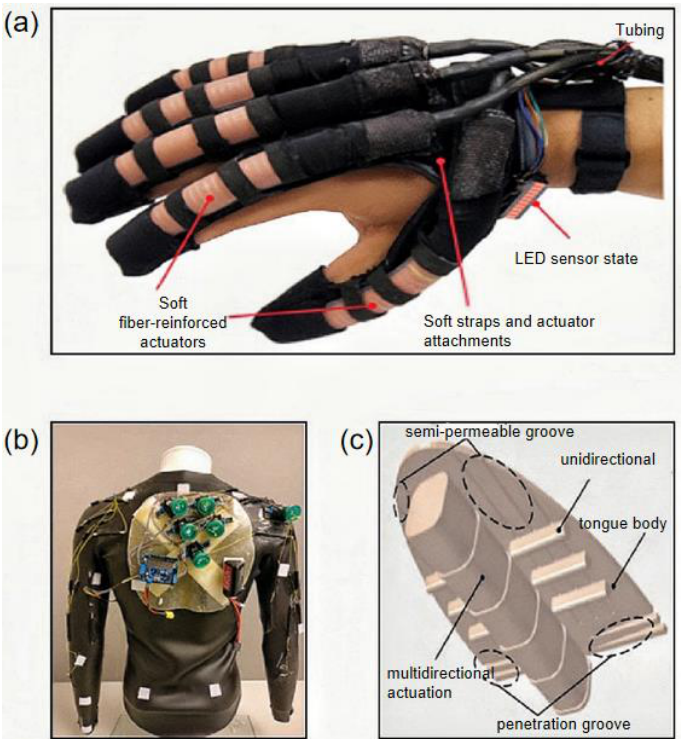
Figure 11. ( a ) The prototyped soft and lightweight robotic hand assistive device [137]. ( b ) CRUX: a soft, lightweight (1.3 kg), robotic eXosuit [138]. (c) CRUX: a soft, lightweight (1.3 kg), robotic eXosuit [139].